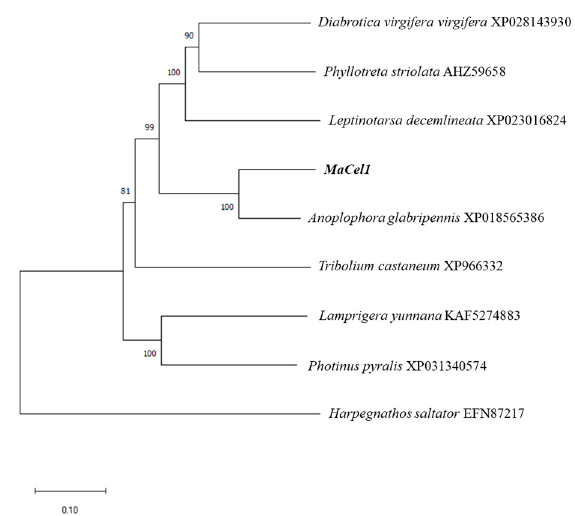
Figure 4. MaCel1 phylogenetic tree based on amino acid sequence.